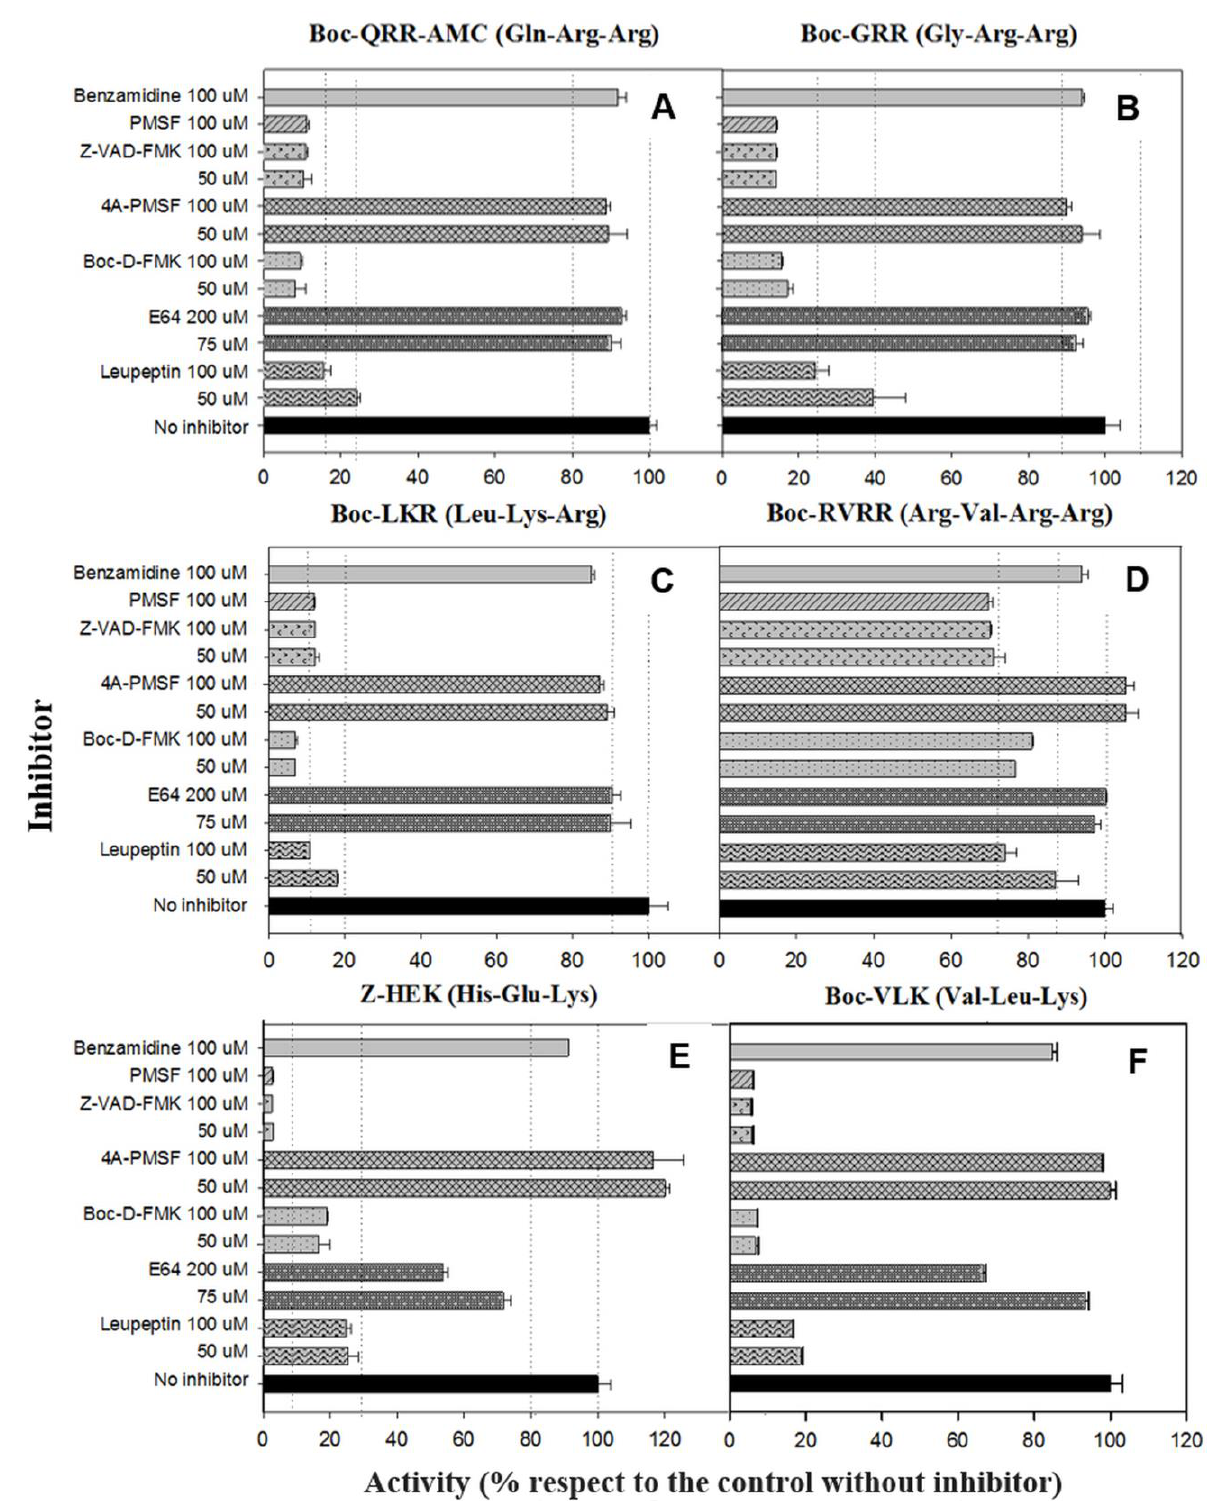
FIGURE 6. Inhibition of Rase and Kase enzymatic activities with several reversible and irreversible inhibitors at different concentrations. RVRRase (A) ; GRRase (B) ; QRRase (C) ; LKRase (D) ; VLKase (E) ; HEKase (F)